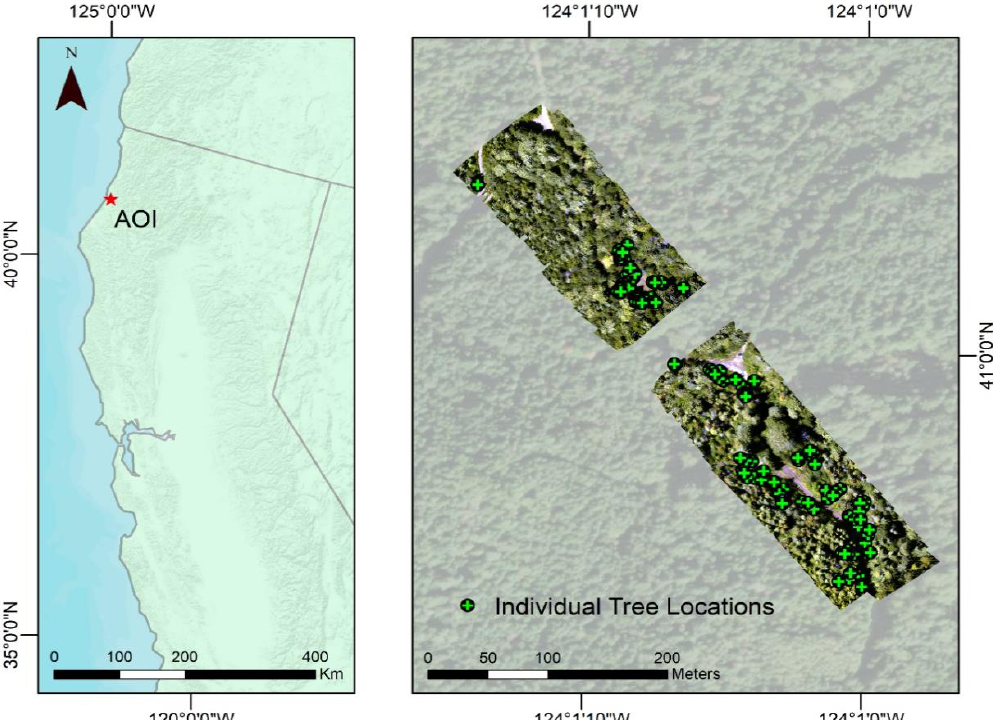
Figure 1. The area of interest (AOI) located in Humboldt County in Northern California. The extent of the hyperspectral imagery is shown on the right totaling 4.85 ha and the individual trees used to train the models.